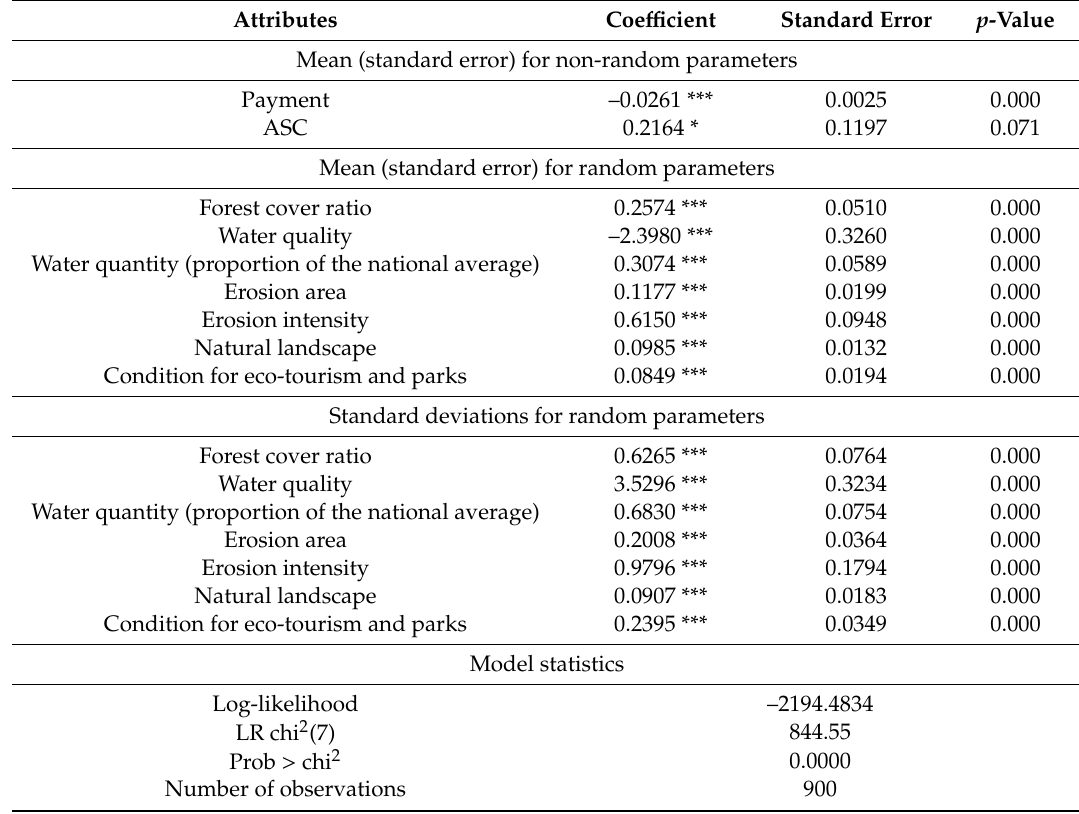
Table 6. Results obtained using the random parameter logit